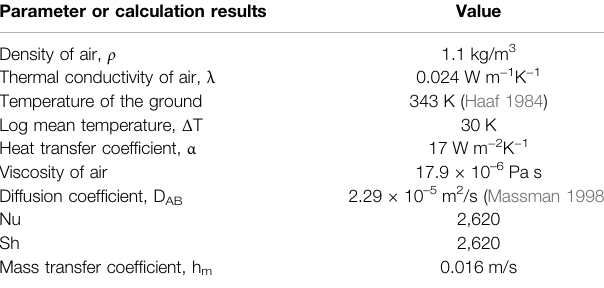
TABLE 3 | The key parameters and calculation results.